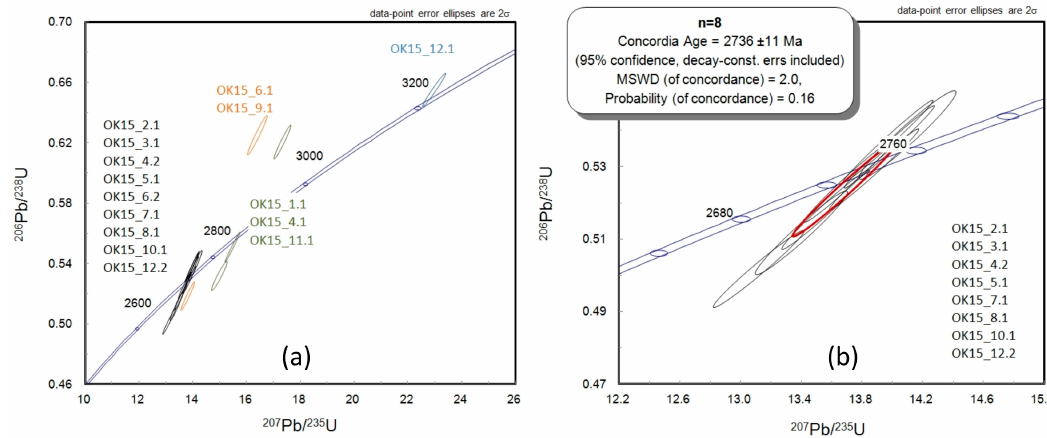
Figure 13. U–Pb isotopic data for zircons from OK-15 sample (DW block): ( a ), all grains measured and ( b ), grains involved in age calculation.